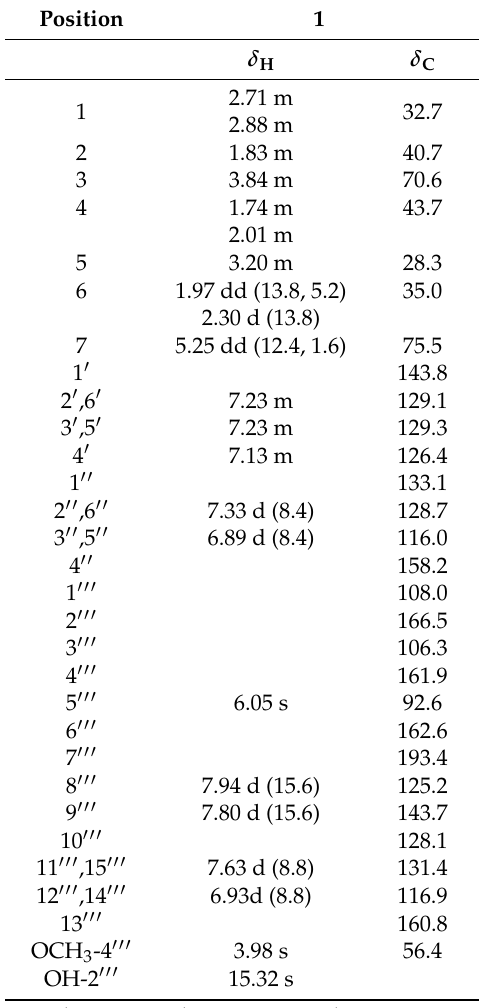
Table 2. 1 H-(400 MHz) and 13 C-(100 MHz) NMR data for compound 1